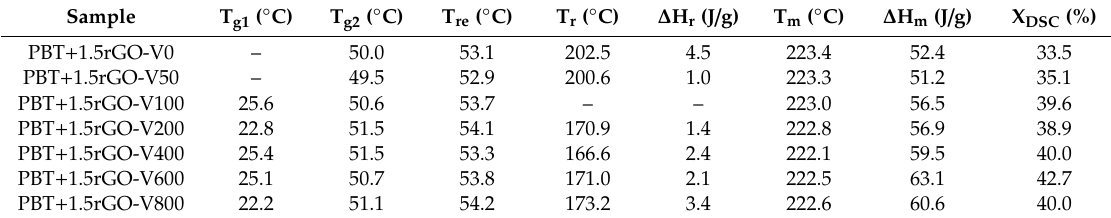
Figure 7. DSC curves of the PBT+1.5rGO fibers formed at different take-up velocities. Table 2. Values of the characteristic temperatures of glass transitions (T g1 , T g2 ), the enthalpy relaxation peak (T re ), recrystallization (T r ) and melting (T m ), enthalpies of melting ( ∆ H m ) and recrystallization ( ∆ H r ), and index of crystallinity (X DSC ) of the studied PBT + 1.5rGO fibers, determined based on the DSC